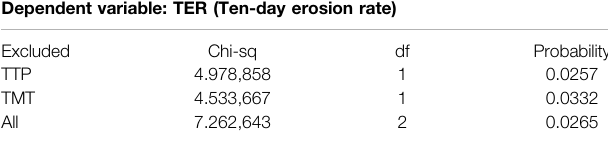
TABLE 3 | Granger causality test results. Dependent variable: TER (Ten-day erosion rate)